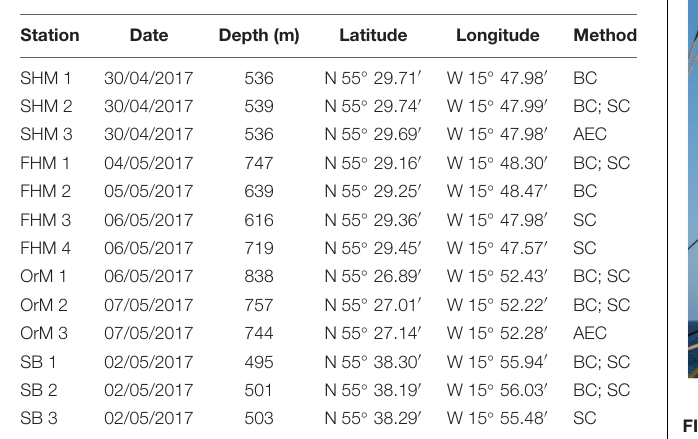
TABLE 1 | Station characteristics; date, depth, latitude, longitude, and applied